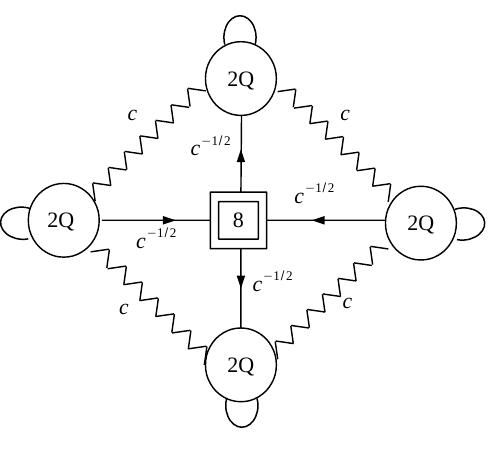
Figure 13: Gluing 2 n ( 1 flux preserving SU ( 2 )